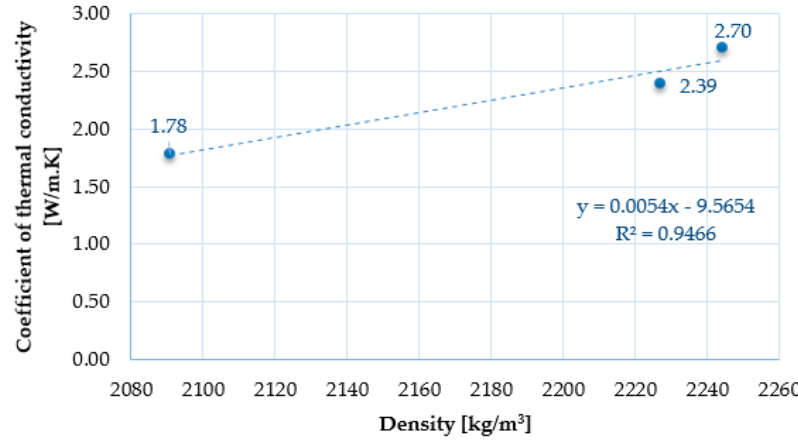
Figure 4. Relationship between density and thermal conductivity of prepared composites.